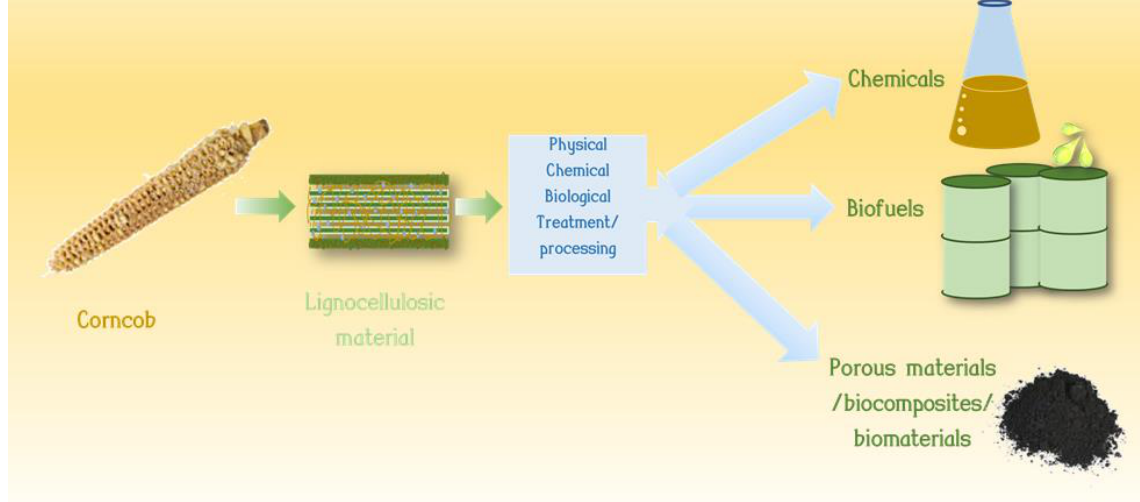
Fig. 2. Utilization of corncob residue for value-added